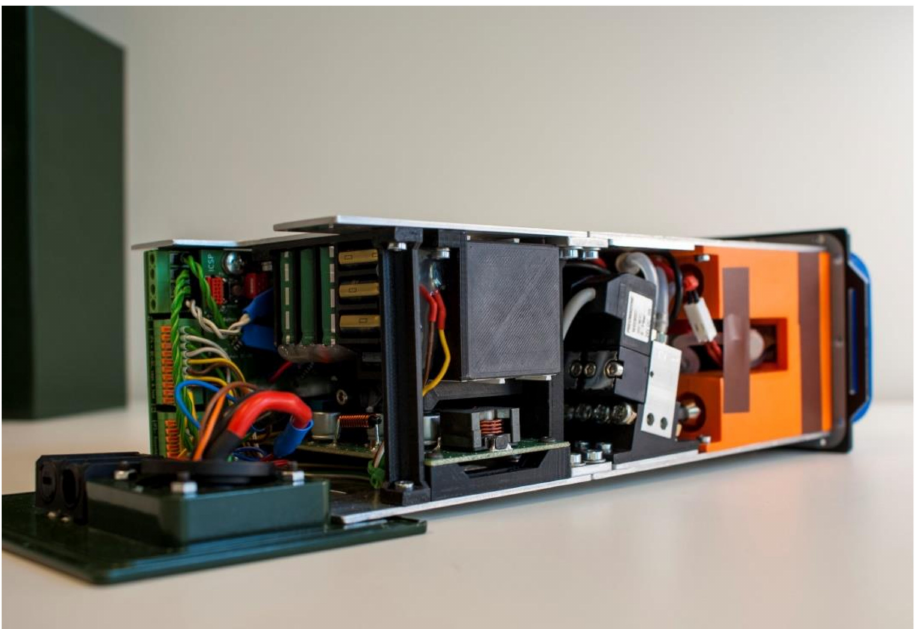
Figure 6. Physical model of the hybrid energy storage system.